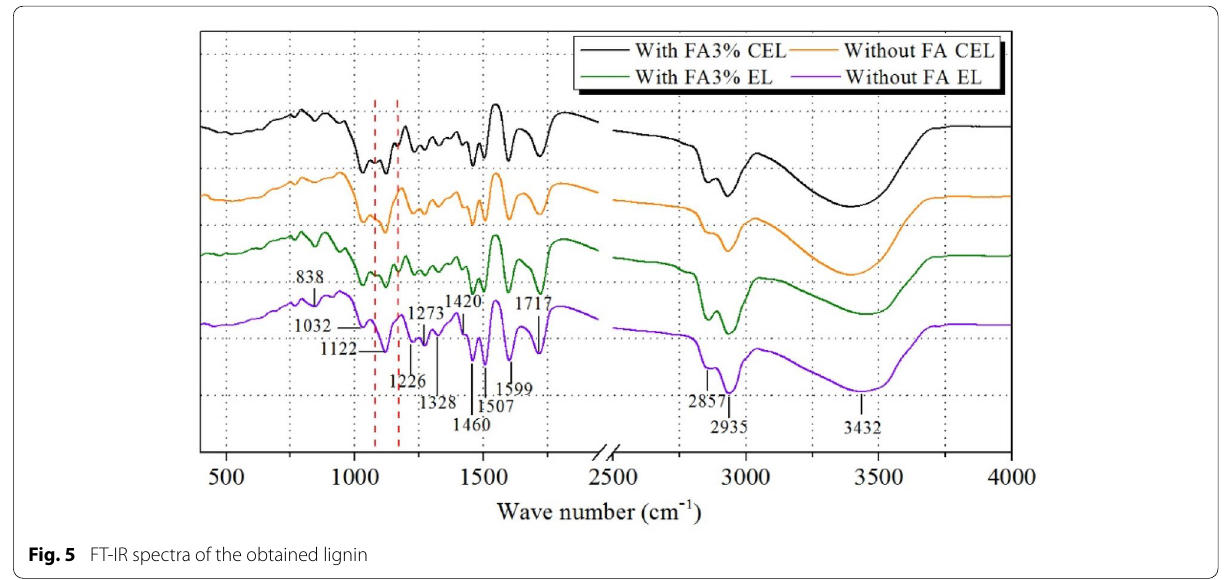
Fig. 5 FT-IR spectra of the obtained lignin